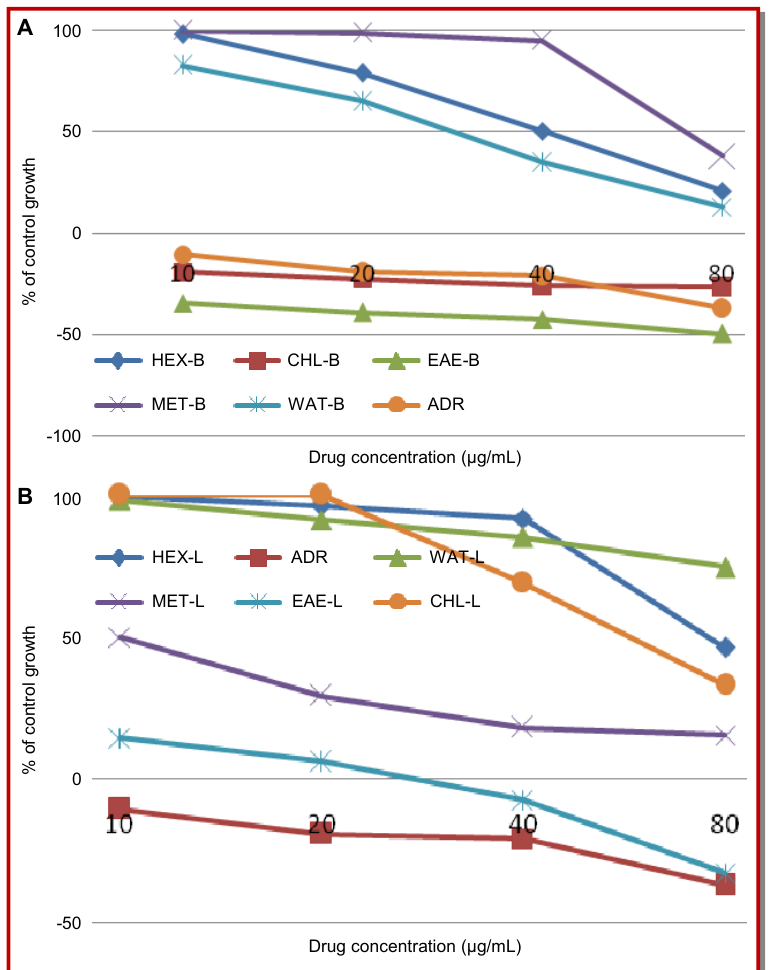
Figure 1: Effect of bulb (A) or leaf (B) extracts of Drimia nagarjunae on the percentage control growth of Colo205